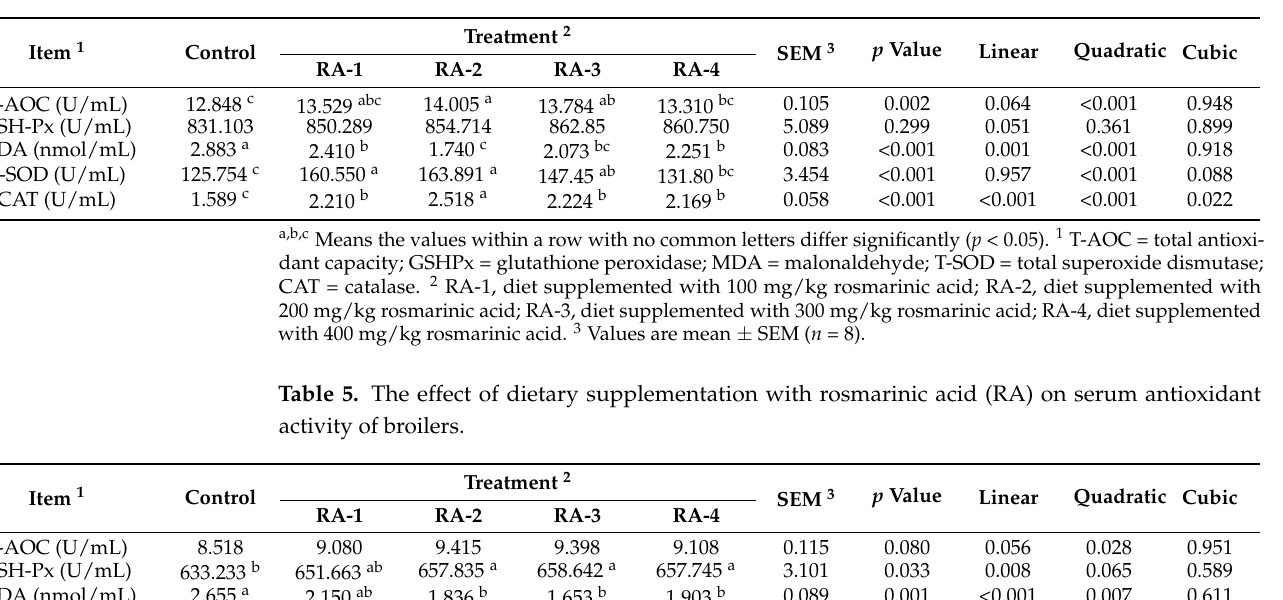
Table 4. The effect of dietary supplementation with rosmarinic acid (RA) on liver antioxidant activity of broilers.